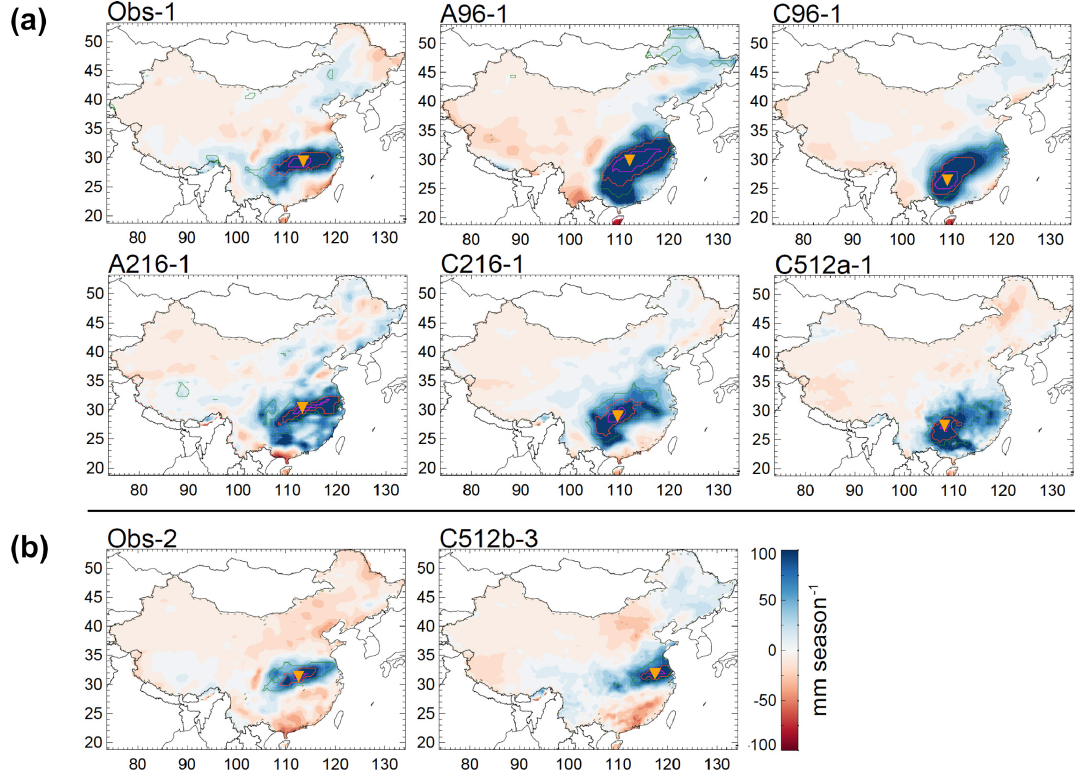
Figure 10. Shading shows regressions of JJA precipitation against observed or simulated EOT time series. Also shown are positive (solid lines) and negative (dashed lines) correlations of the full (leading-order) or residual (higher-order) precipitation-anomaly time series with the EOT base point exceeding 0.8 (magenta), 0.6 (orange) and 0.4 (green). The EOT base point is marked by the orange inverted triangle. Panel (a) shows patterns that have a linear correlation coefficient exceeding 0.38 with the first observed pattern and (b) with the second observed pattern. The number next to the simulation name above each panel indicates the order of the simulated EOT